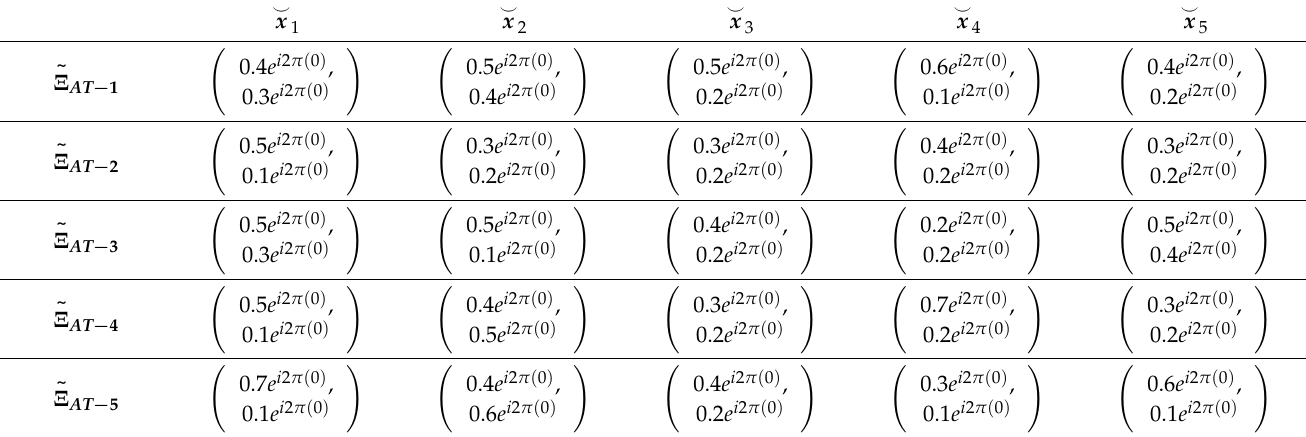
Table 9. Original decision matrix for candidates (cid:101) Ξ CI − 3 .